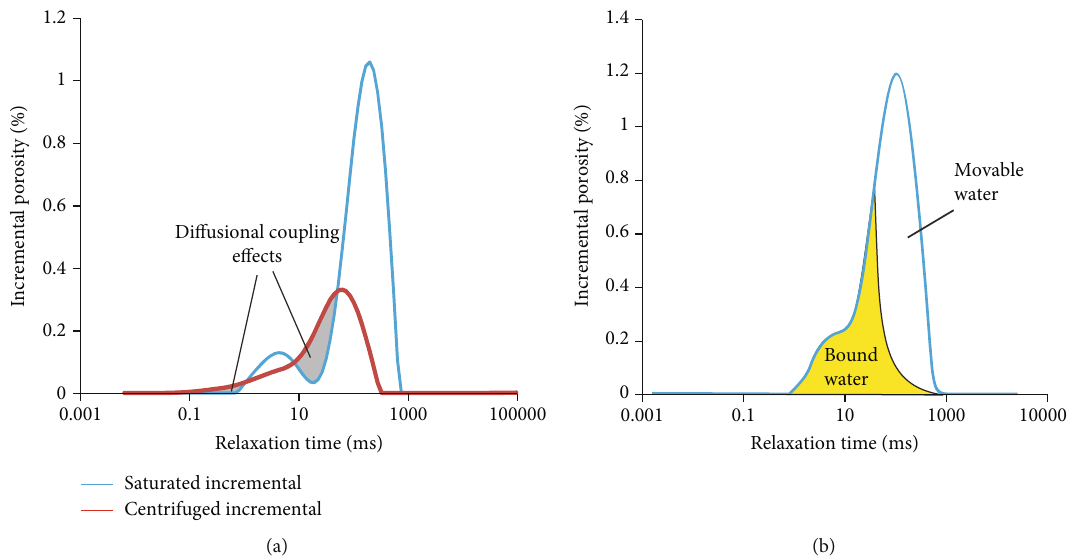
Figure 7: (a) Di ff usion coupling e ff ect (well H2, 2464.63m, Kh [57].